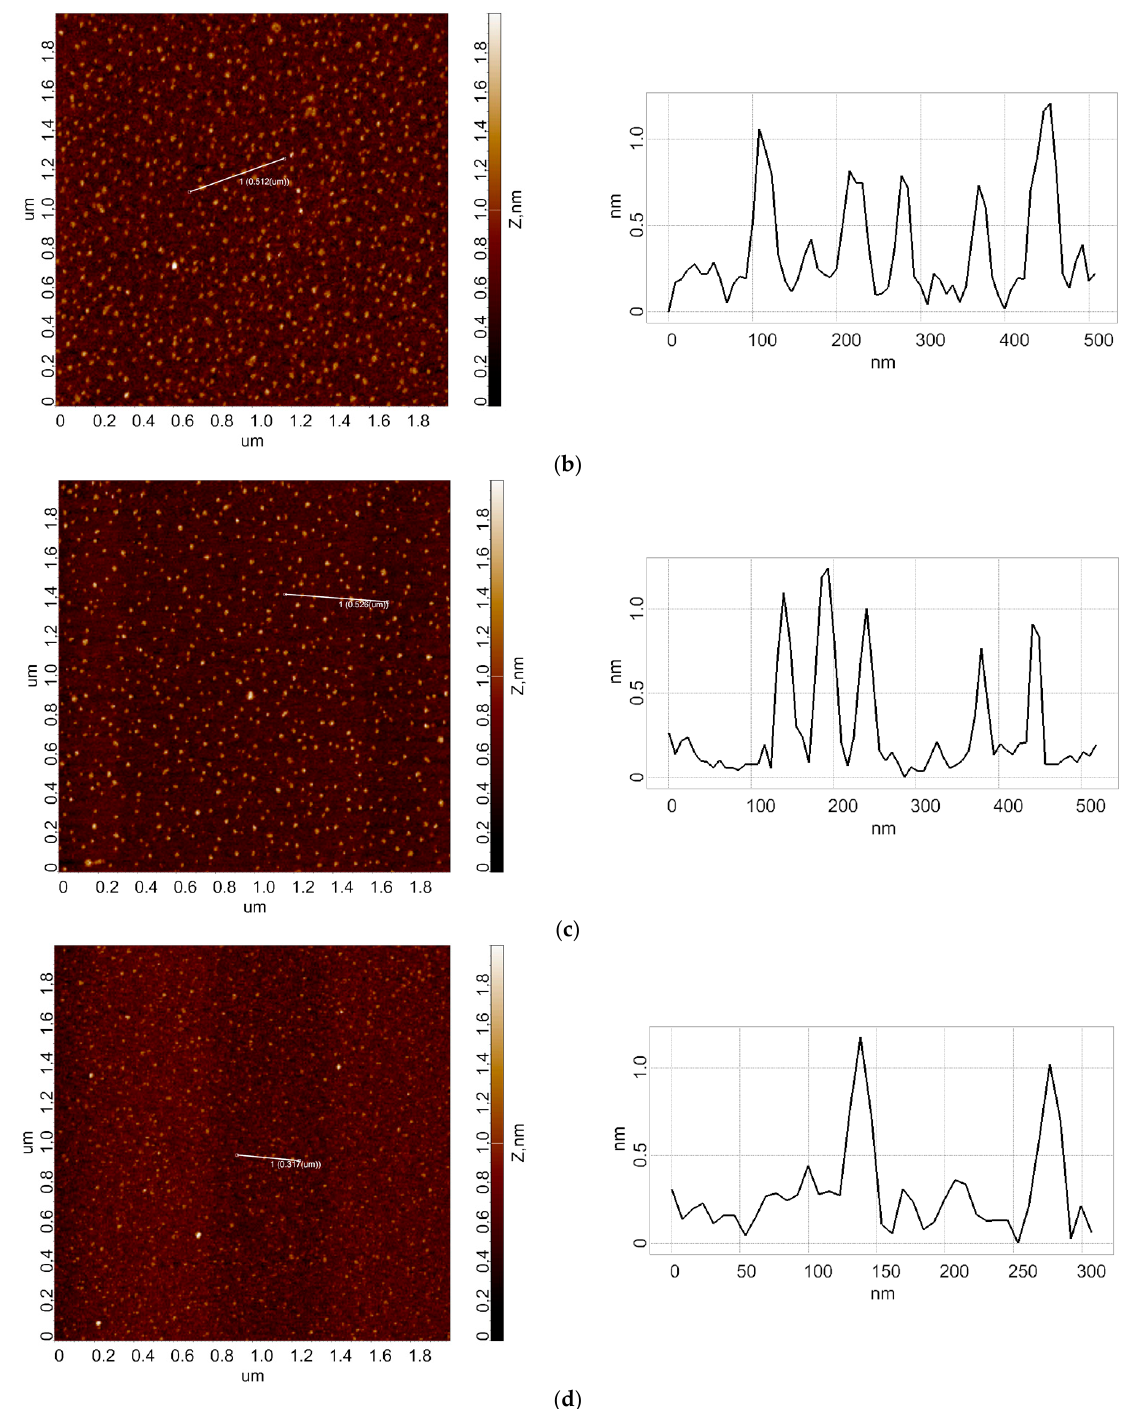
Figure 2. Typical AFM images of mica surface with adsorbed HRP (left) and their respective cross section profiles (right) obtained for working and control HRP solutions. Experimental conditions: w = 0 (non-rotating cone), t = 10 min (control) ( a ); w = 10,000 (rotating cone), t = 10 min (working experiment) ( b ); w = 0 (non-rotating cone), t = 20 min (control) ( c ); w = 10,000 rpm (rotating cone), t = 20 min (working experiment) ( d ). For all AFM images presented, the scan size was 2 µ m × 2 µ m, and the Z scale was from 0 to 2